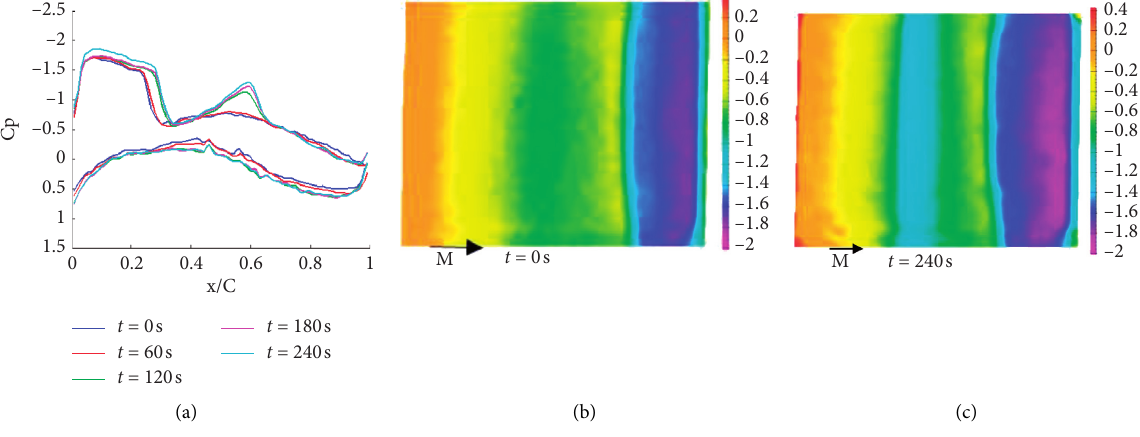
Figure 17: Wind tunnel test results (PSP, M � 0.7 and α � 6 ° , test).